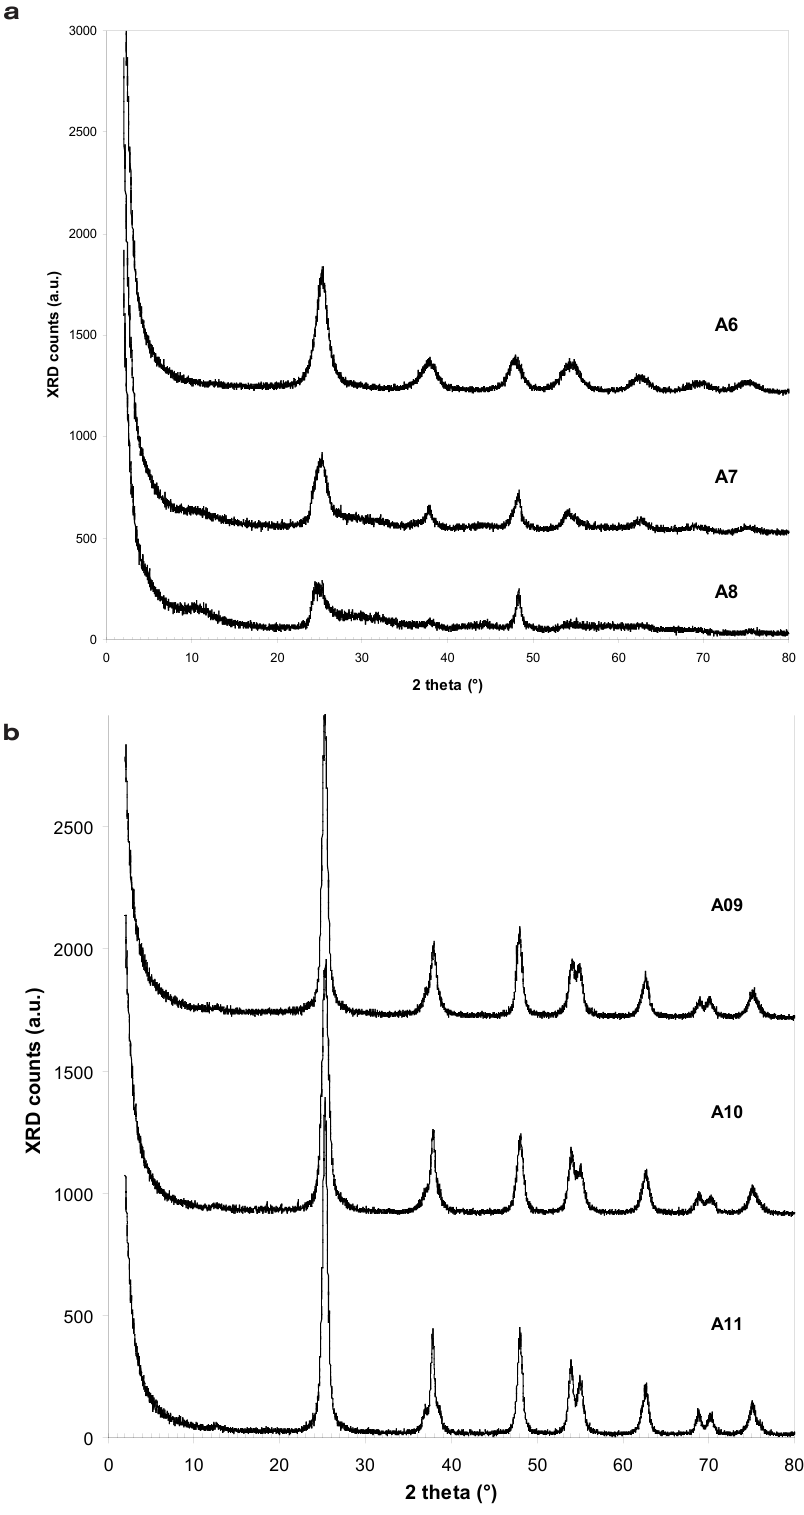
Figure 4. XRPD patterns of a) samples prepared through acid post-treatment at 80°C and b) samples prepared through acid post-treatment at